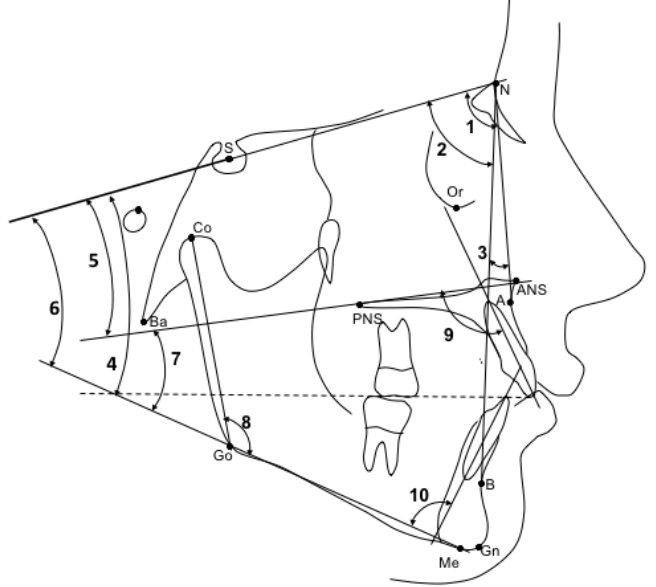
Figure 1. Angular variables considered in the study.